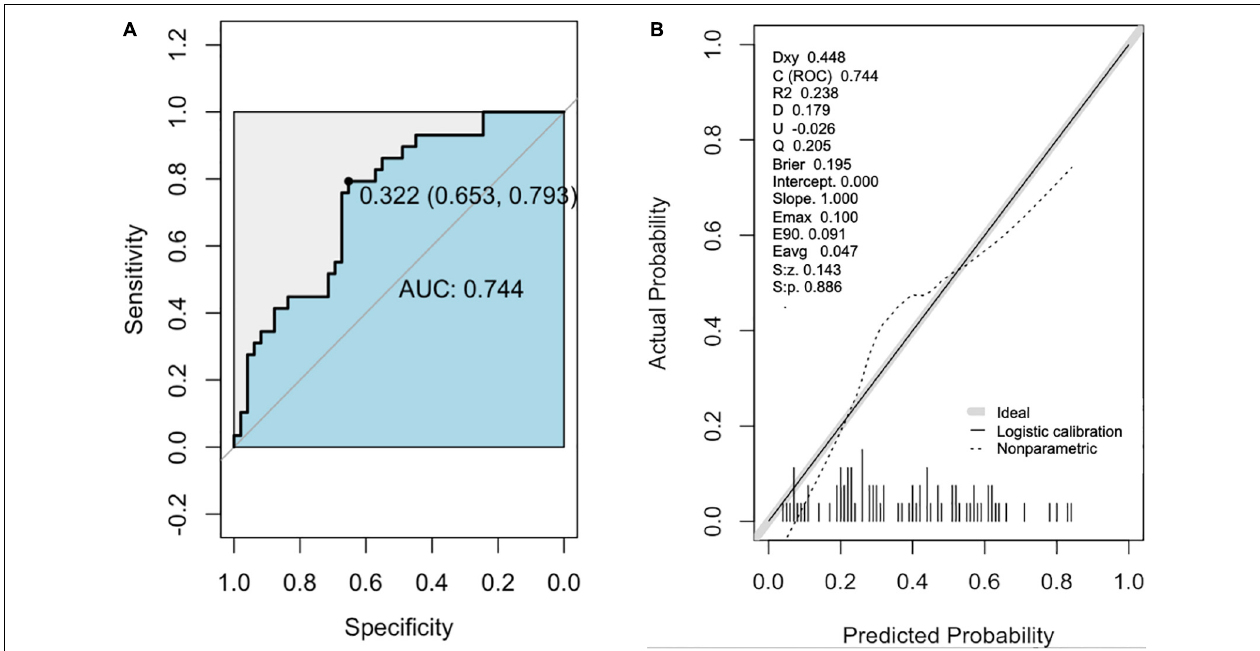
FIGURE 3 | The receiver operator characteristic (ROC) curve and Calibration curve of the nomogram for predicting in patients with PsA. (A) ROC curve of the predictive model for CP+. (B) Calibration curves of the predictive model for CP+. The black line represents a great fit between the nomogram predicted probability ( x -axis) and the observed probability of actual diagnosed cases of CP+ ( y -axis). The dotted line represents performance of the present nomogram. Closer fit between the two lines indicates a higher prediction accuracy. CP+, the presence of carotid plaque.